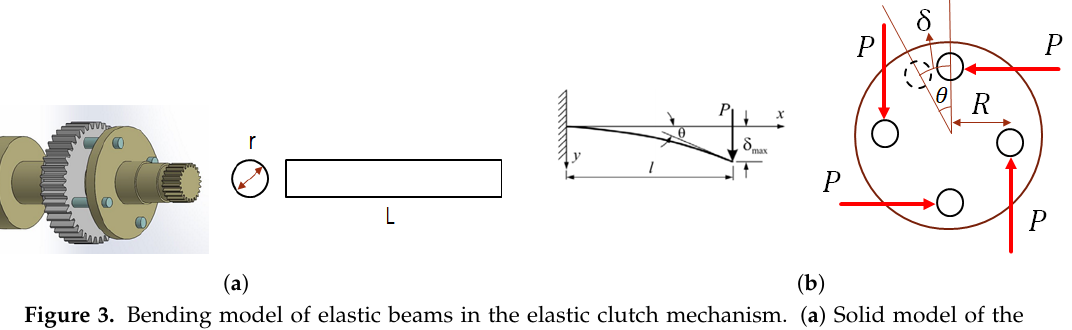
Figure 3. Bending model of elastic beams in the elastic clutch mechanism. ( a ) Solid model of the elastic clutch mechanism and the dimensions of the cantilever beams, ( b ) Bending model of the elastic clutch